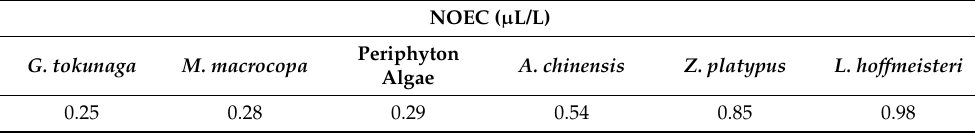
Table 7. No observed effect concentration (NOECs) for each species.